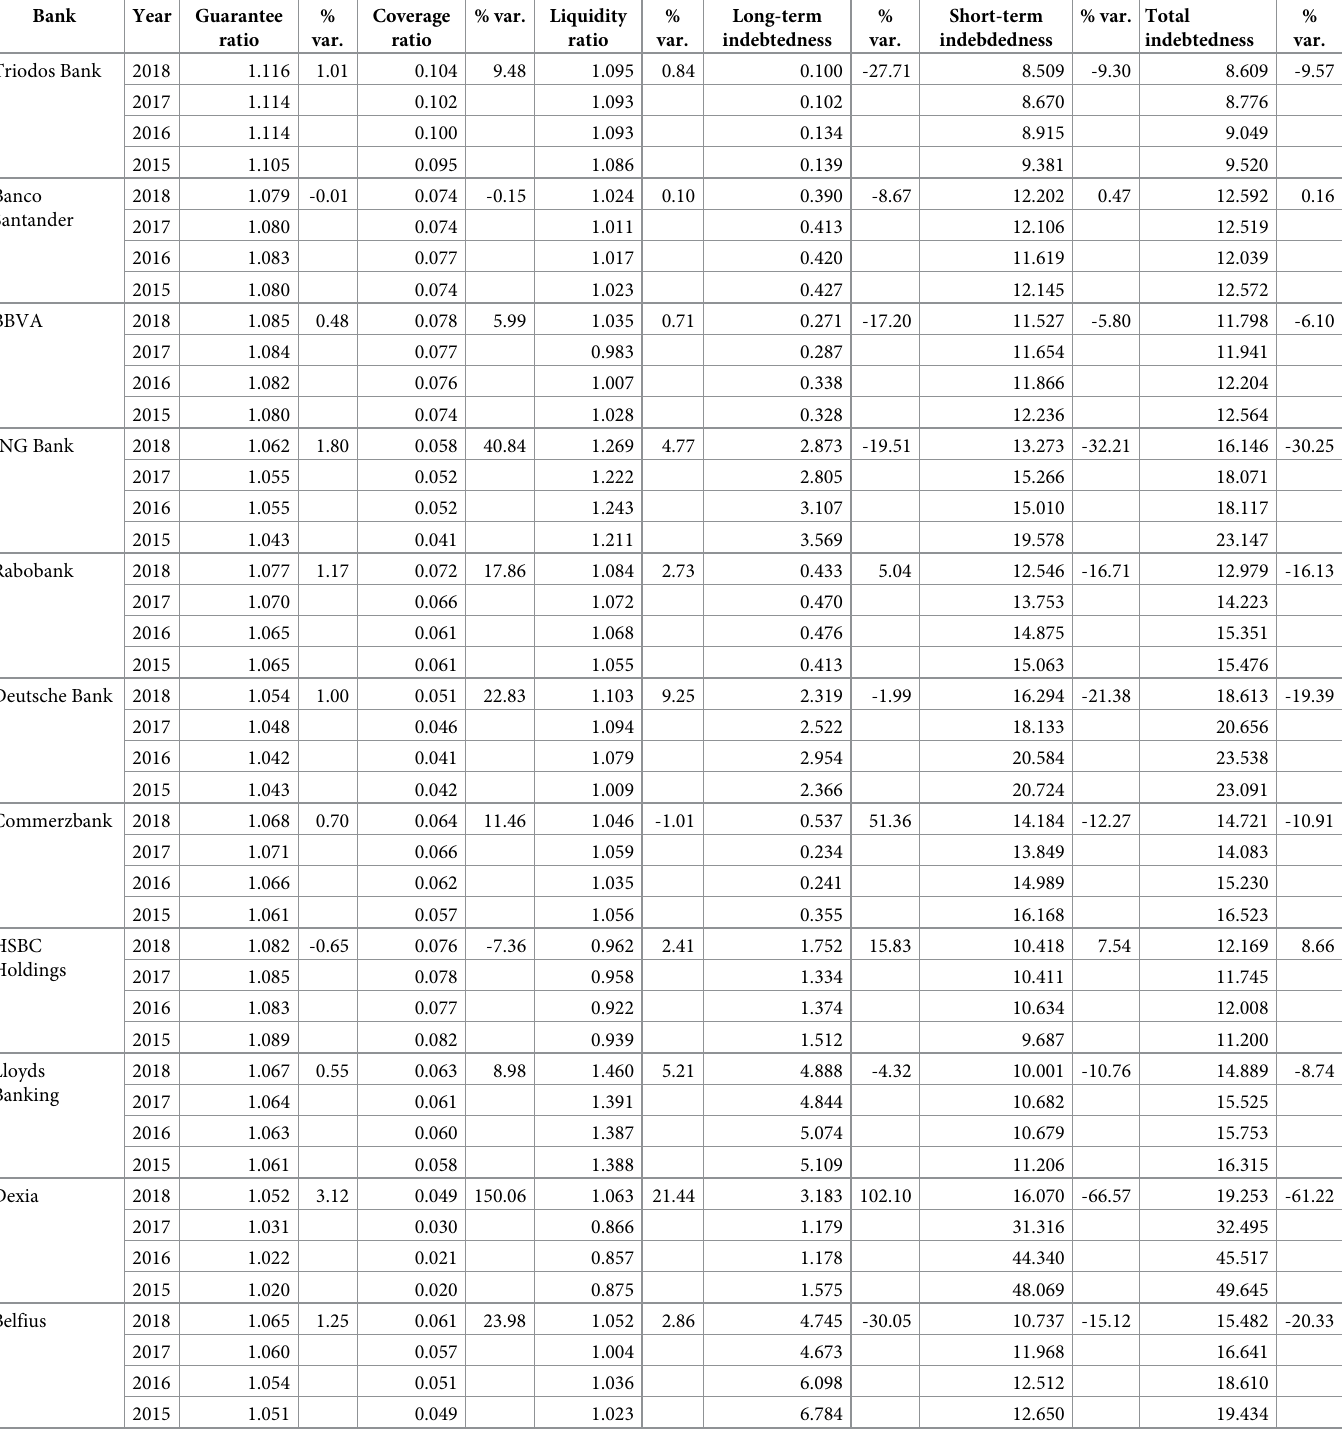
Table 6. Guarantee, coverage, liquidity and indebtedness ratios.